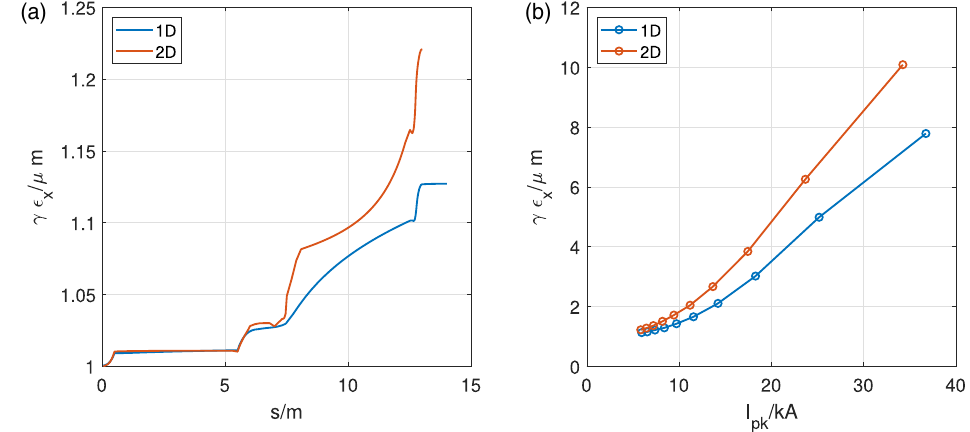
FIG. 6. Comparison of emittance growth calculated by 1D and 2D models. (a) Normalized emittance growth inside the chicane as a function of longitudinal coordinates s , with energy chirp h ¼ 36 m − 1 . Dispersion is subtracted with second order polynomial fitting. (b) Final emittance at the end of the chicane as a function of final peak [Fig. 5(a) and (b)], 2D models show large deviation from 1D model due the beam tilt in x – z plane and therefore the transverse size of the bunch becomes much larger than the longitudinal one. As a comparison, in the last magnet the results from 1D and 2D methods converge as the tilt vanishes.